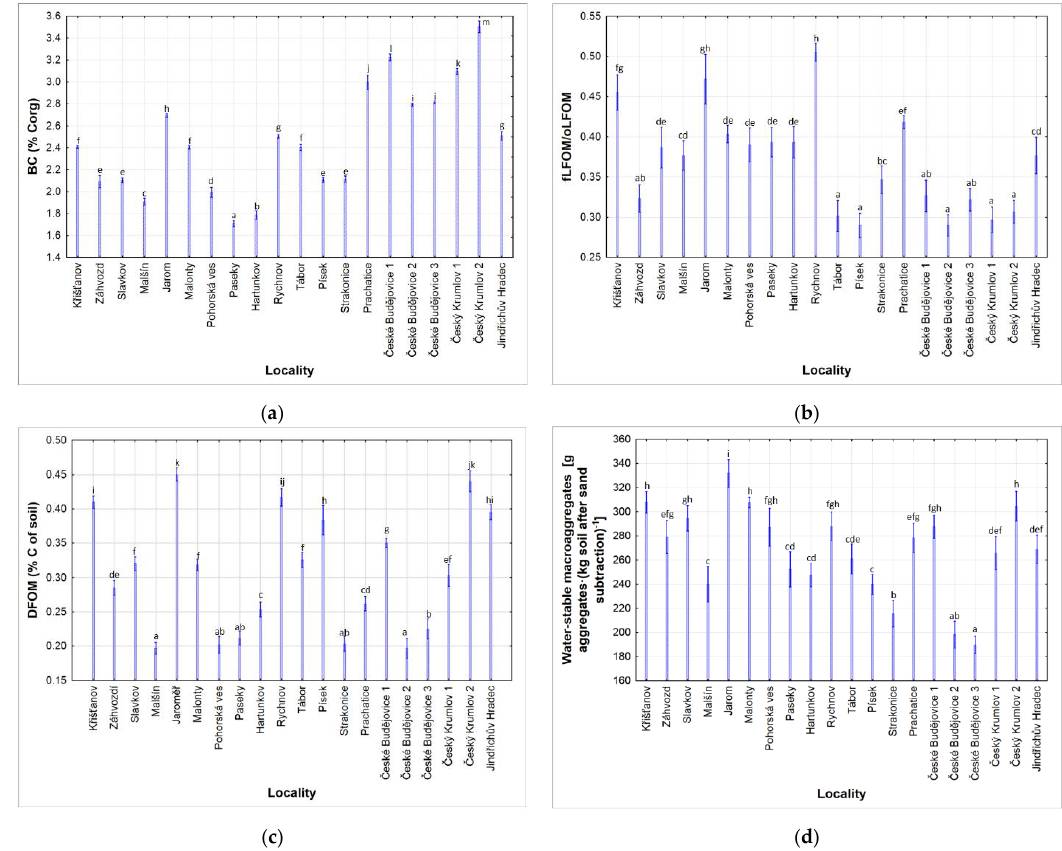
Figure 2. Amounts of soil organic matter fractions monitored in samples of clay Cambisols (ANOVA, p < 0.00001): ( a ) Black carbon; ( b ) the ratio of free light fraction and the occluded light fraction of soil organic matter; ( c ) the organic matter of the heavy soil fraction; ( d ) water-stable macroaggregates. Note: BC — black carbon (F (19, 100) = 1494.3); fLFOM/oLFOM — the ratio of free light fraction and the occluded light fraction of soil organic matter (F (19, 100) = 76.991); DFOM — the organic matter of the heavy soil fraction (F (19, 100) = 343.35). Water-stable macroaggregates (F (19, 100) = 69.371); significant differences between localities are shown in letters (Tukey’s honest significance test; p =